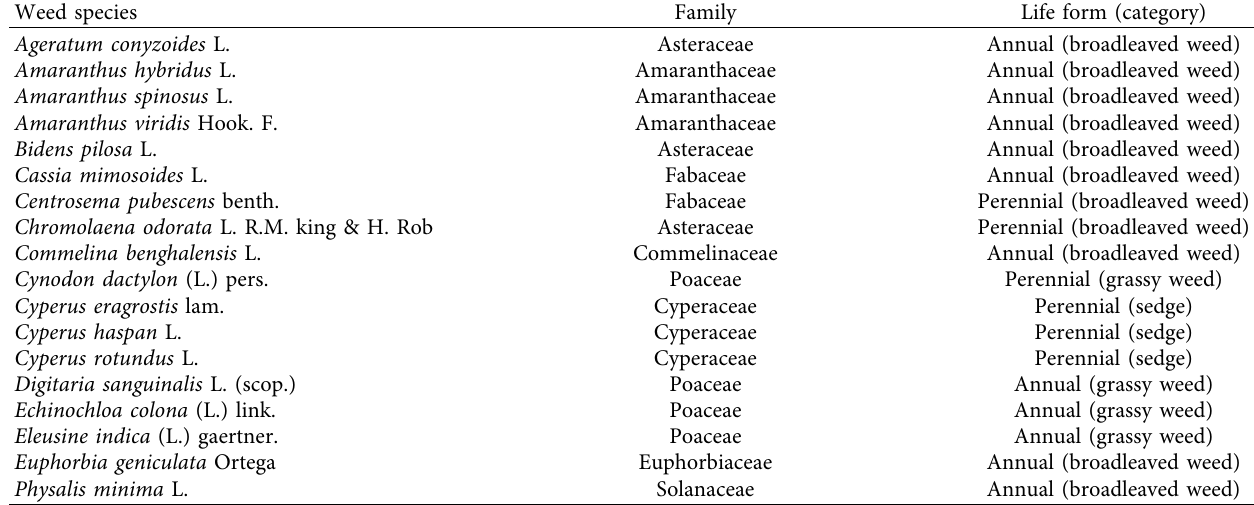
Table 1: Weed community recorded in a rice field at the experimental site in 2020 main cropping season. Weed